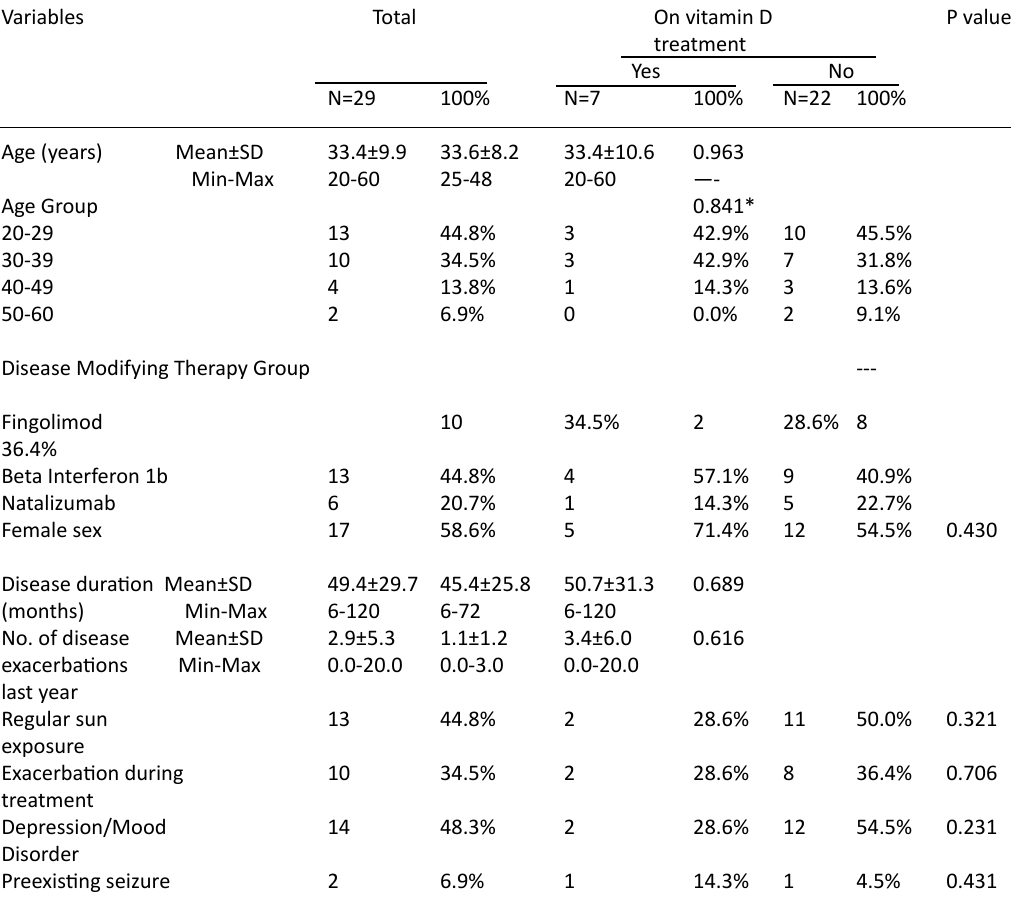
Table 2. Characteristics of sampled